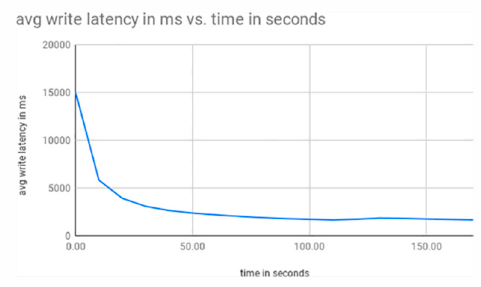
Figure 17. Average commands latency (in ms) curve versus the time in seconds.